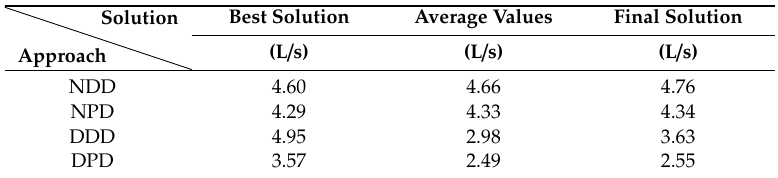
Table 3. MAE regarding the simulated flow rate of the Best solution, the Average values and the Final solution with respect to the reference network.